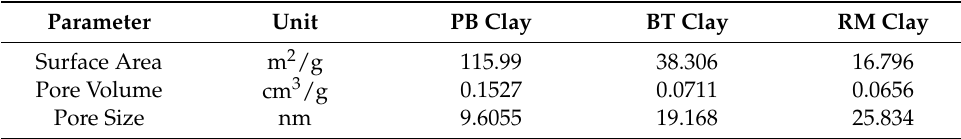
Table 2. Surface and pore characteristics of the NICs